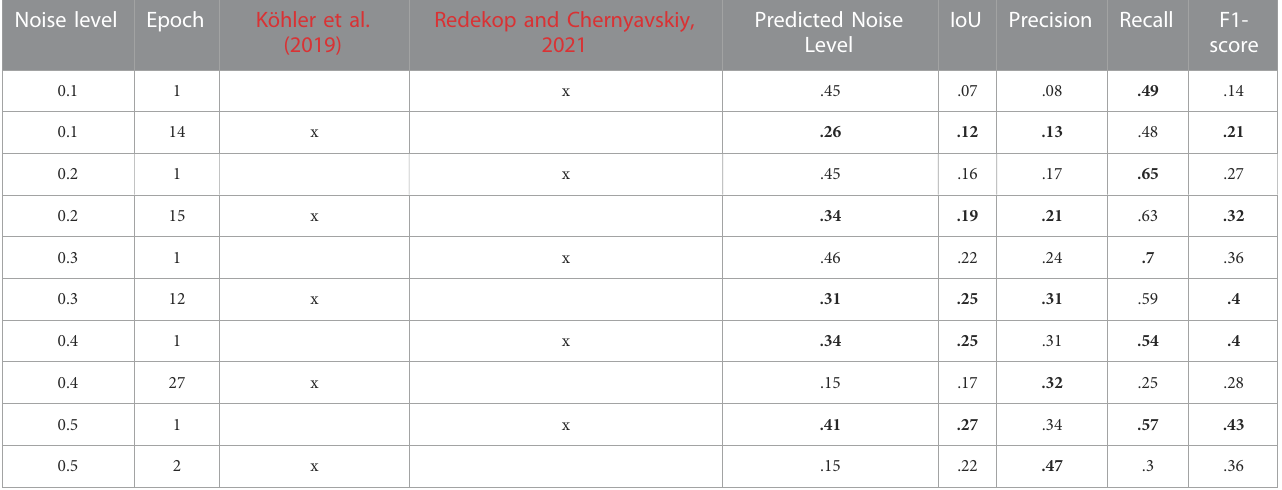
TABLE 1 Table of pixel-wise accuracy metrics for pixels classi fi ed as “ noisy ” by the betamix algorithm versus known omission noise. The method proposed by Köhler et al. (2019) uses the standard deviation of softmax values of the building class σ 0 to select an epoch, and the mean softmax values of the predicted class μ , within the chosen epoch to identify noisy samples. The method proposed by Redekop and Chernyavskiy, 2021 uses the difference in Var al for epoch selection and Var al for identi fi cation. Bold values show the best result for each noise level between the two